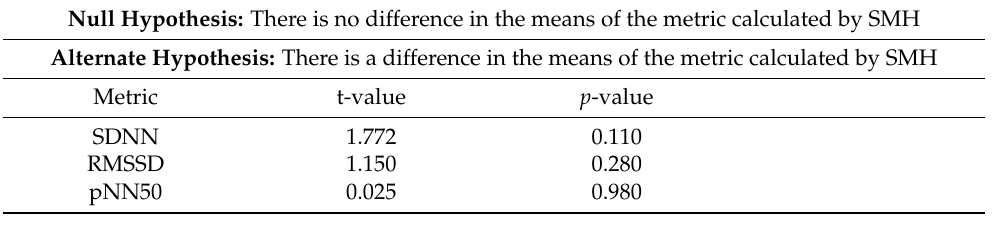
Table 2. Paired Student’s t -test to check if there is any difference in the observations obtained for Fitbit data using SMH in comparison with Polar H10 data on